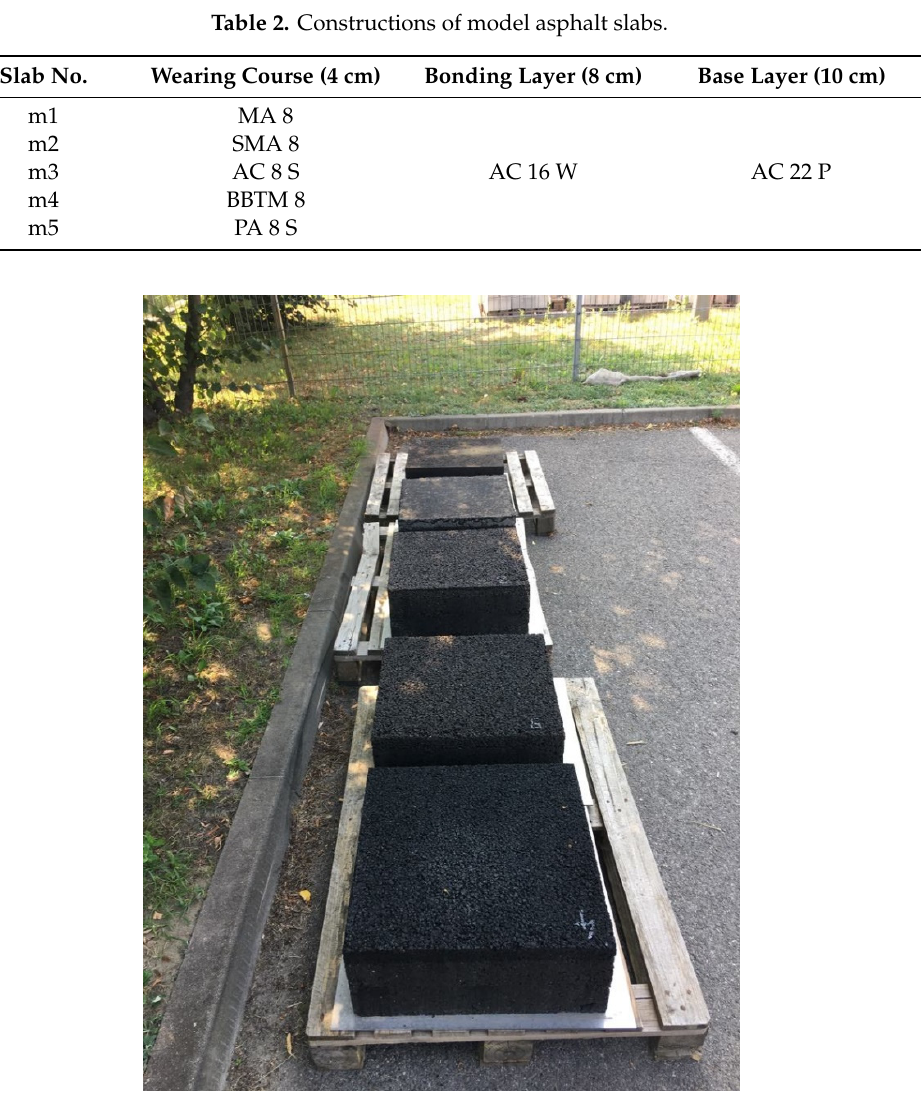
Figure 2. Tested model asphalt slabs. Table 3. Atmospheric conditions during GPR